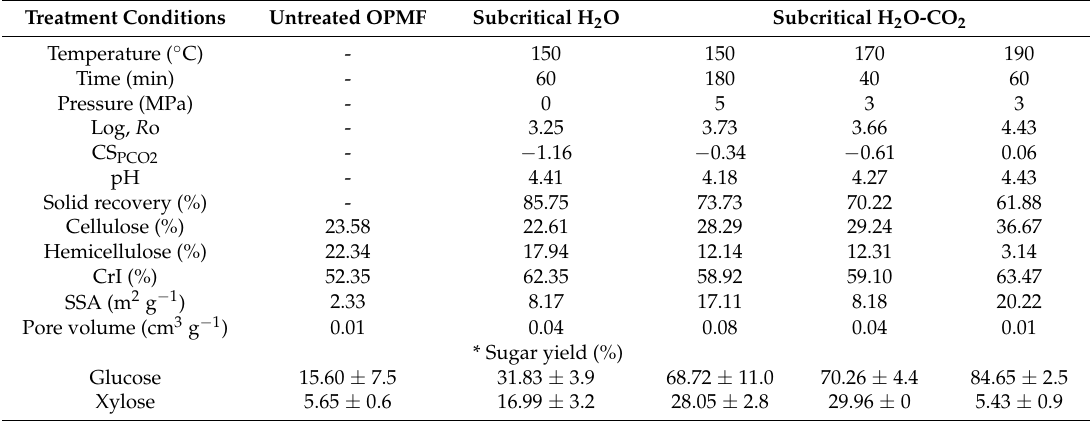
Table 3. Effect of subcritical H 2 O-CO 2 pretreated solids on cellulose crystallinity index, specific surface area and sugar